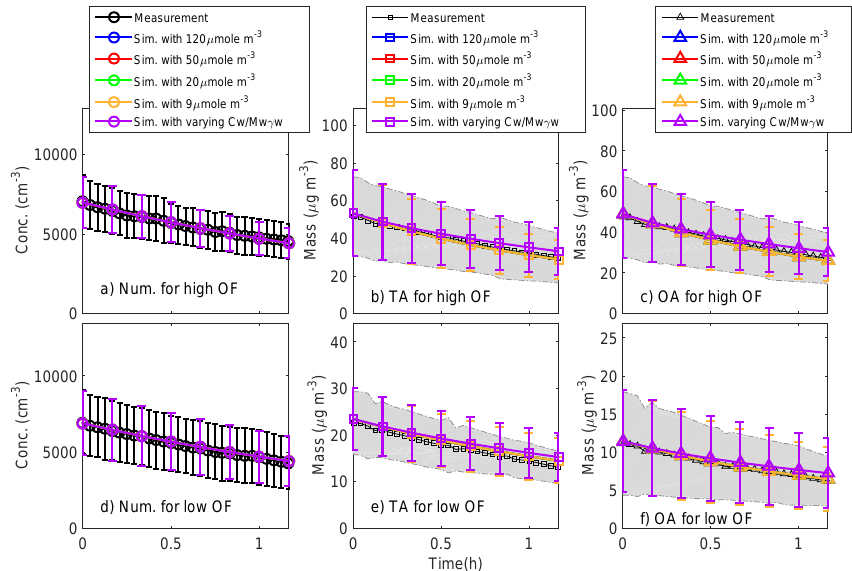
Figure 7. Similar to Fig. 2 except using different C w /M w γ w of 120 (base-assumption simulation), 50, 20, 9µmolem − 3 and varying C w /M w γ w (adapted from Zhang et al.,